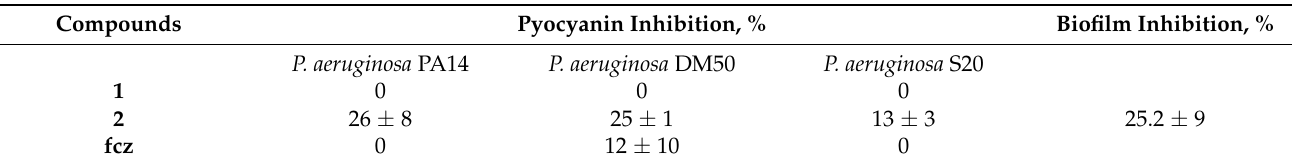
Table 2. Effect of complexes and fluconazole on pyocyanin production and biofilm formation in P. aeruginosa isolates. Tested concentration for pyocyanin assessment was 50 µ g/mL, while for biofilm inhibition was 25 µ g/mL.